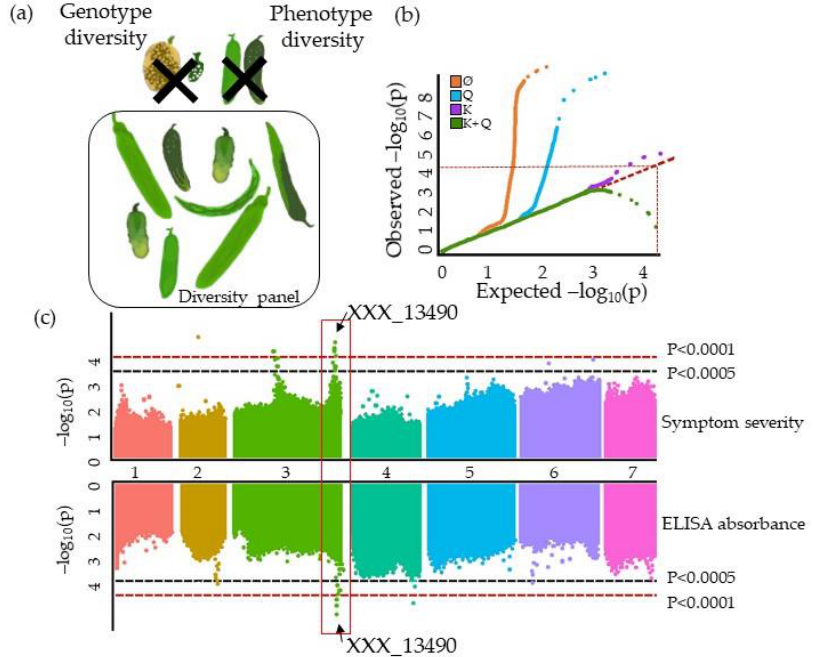
Figure 7. Overview of fictitious GWAS main figures, following pre-GWAS presented in Figure 3 ( a ) genotypes with low quality genetic data and/or too genetically isolated and/or too genetically close from other genotypes or genotypes displaying seldom phenotypes are discarded from the GWAS population. ( b ) QQ-plots for SS T1 for models without covariates (orange) and Q model (blue) present an excess of false positives. Most p -values of the QQ-plot of the K model (purple) are similar to the expected bisector, indicating K model appropriateness. QQ-plot of the Q + K model (green) presents an excess of false negatives and suggests overcorrections. ( c ) Manhattan plots for the two traits, SS above and ELISA absorbance below. The red and the black dashed lines indicate Bonferroni-corrected thresholds. A single QTL exceeds the significance threshold for both traits in the end of chromosome 3. SS displays another peak on the center of chromosome 3, with XXX_13490 being the top SNP, and three single SNPs on chromosome 2 and 6. ELISA absorbance displays three other peaks, respectively on chromosome 2, 4, and 7.